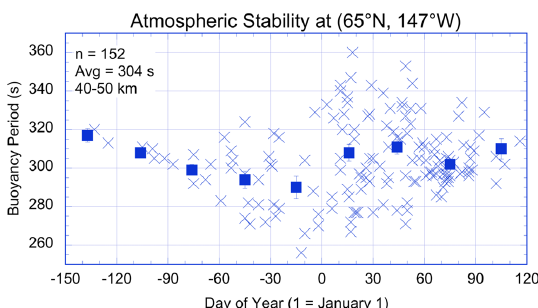
Figure 2. Buoyancy periods measured by Rayleigh LiDAR on 152 nights at Chatanika, Alaska. The data are plotted as the day of year from August to April. The day of year counts from 1 on 1 January, day of year 30 corresponds to 30 January, and day of year -30 corresponds to 1 December. Solid squares represent the monthly average values.